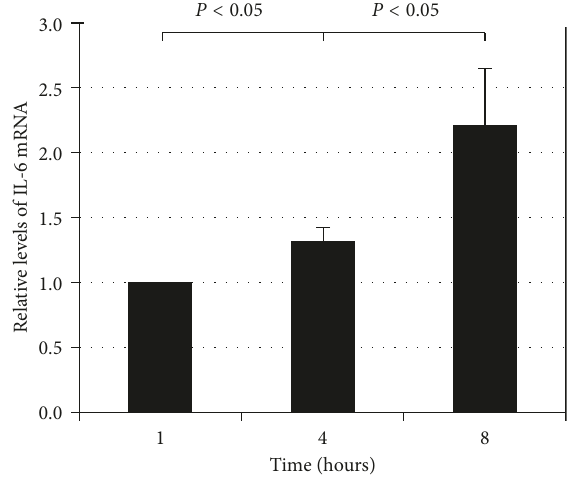
Figure 1: Proteasome inhibition upregulated IL-6 mRNA pro- duction in RPE. ARPE-19 cells were cultured in the presence of MG132 for 1, 4, and 8h. Levels of mRNA for IL-6 were assessed by real-time RT-PCR analysis. GAPDH mRNA was used as a control to normalize the total mRNA levels. The results are the mean ± SD of two independent